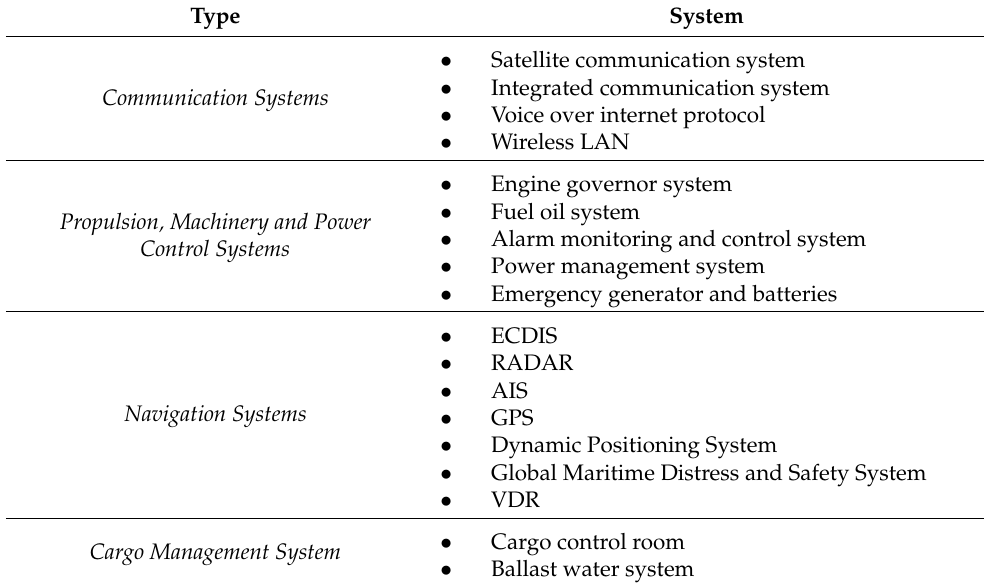
Table 6. Ship OT system types and their components.